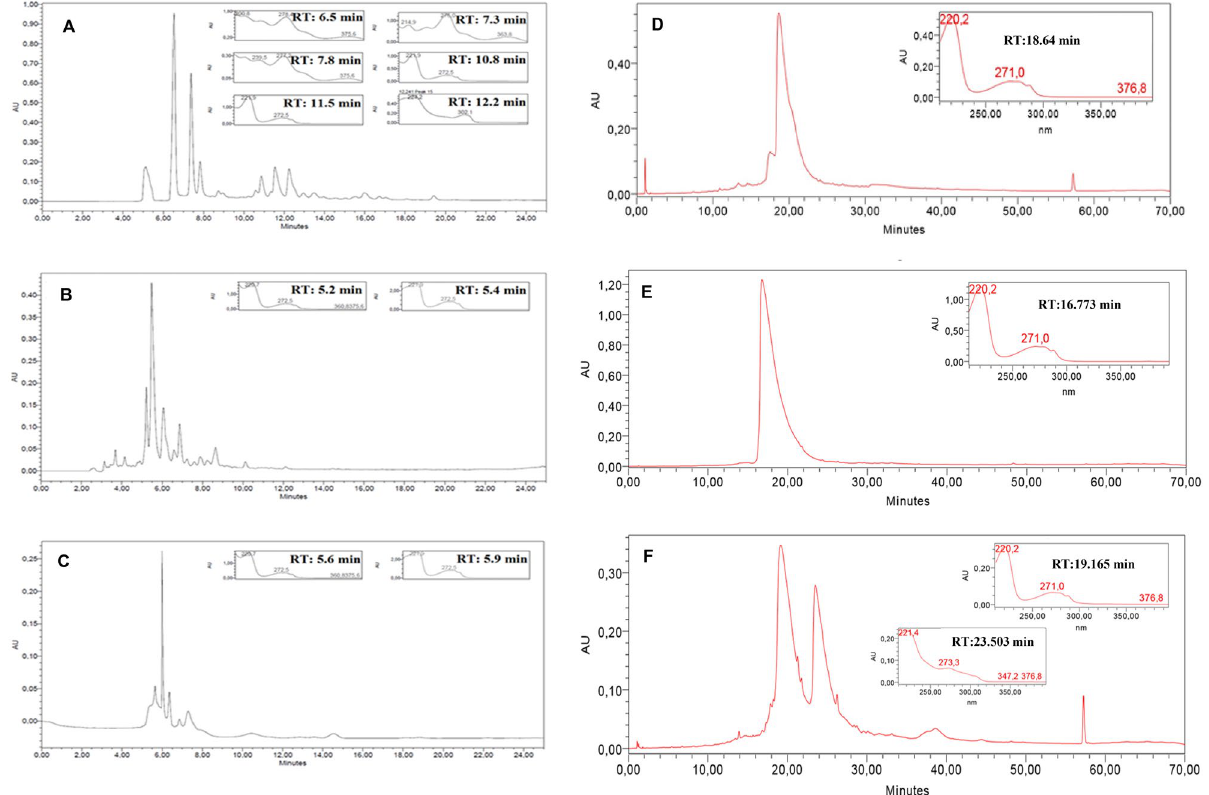
Figure 1. Chromatographic profile and UV spectra of EE, FN, FA and SF5-6, SF8 and SF9 subfractions obtained from A. nitidum . Condition: Column RP-18 (45 × 250 mm, 5 µm), λ 220–400 nm, flow = 1